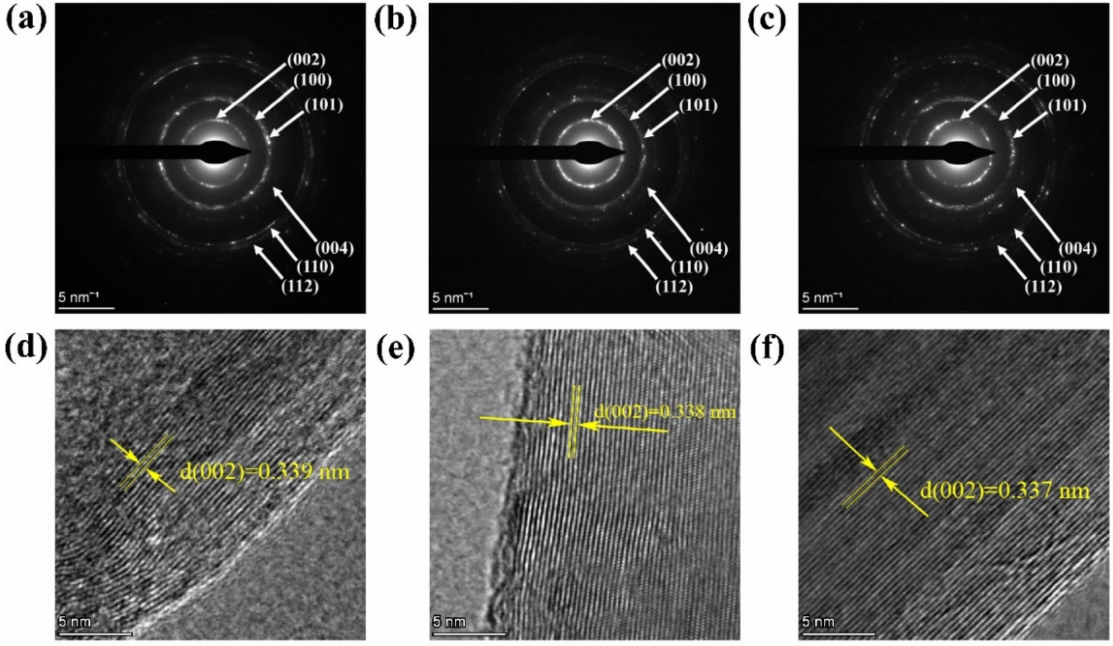
Figure 6. ( a – c ) SAED pattern of 750-2, 800-2, 900-2; ( d – f ) HRTEM images of 750-2, 800-2, 900-2. Combining the results of XRD, XPS, Raman, TEM, and SAED, it can be seen that graphitic carbon is produced with the catalysis of Ni. In the first step, Ni 2+ is oxidized to NiO; in the second step, at a specific temperature, NiO reacts with amorphous carbon and is reduced to Ni; in the third step, during the dissolution and precipitation of metallic Ni, it reacts with the surrounding amorphous carbon to form graphitic carbon